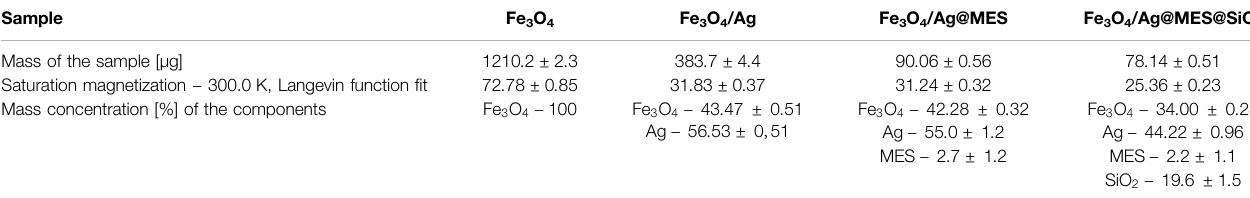
TABLE 2| Magneticpropertiesand estimated masscompositionoftheFe 3 O 4 /Ag@MES@SiO 2 andintermediateproducts based onSQUID.magnetometry measurements.